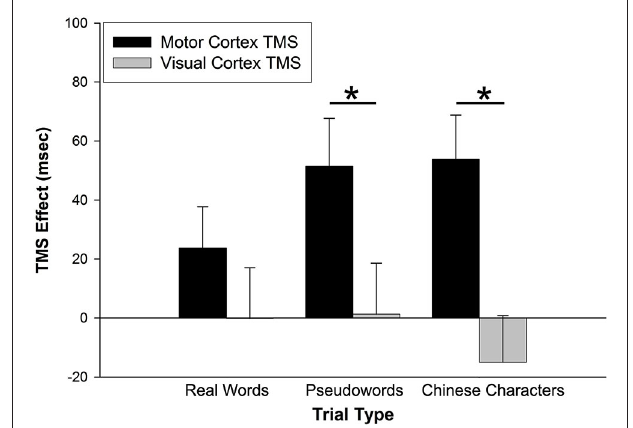
FIGURE 2 | TMS effects on RT . The TMS effect represents the difference between primary motor cortex (M1) and visual cortex (VC) RT minus Sham RT. M1 stimulation slowed RTs for pseudoword and Chinese character trial types. VC stimulation had no effect on RTs. Error bars denote standard error. * p <